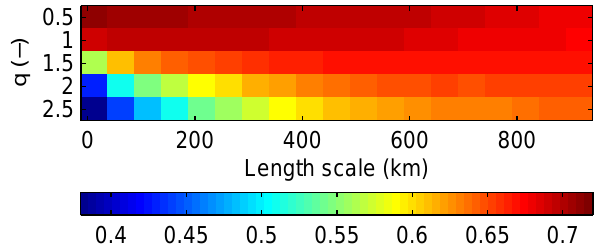
Fig. 4. Variability of the correlation coefficient C(q,L) between ¯ τ a and ˜ m q,L , calculated for seasonally detrended data from the whole data set.